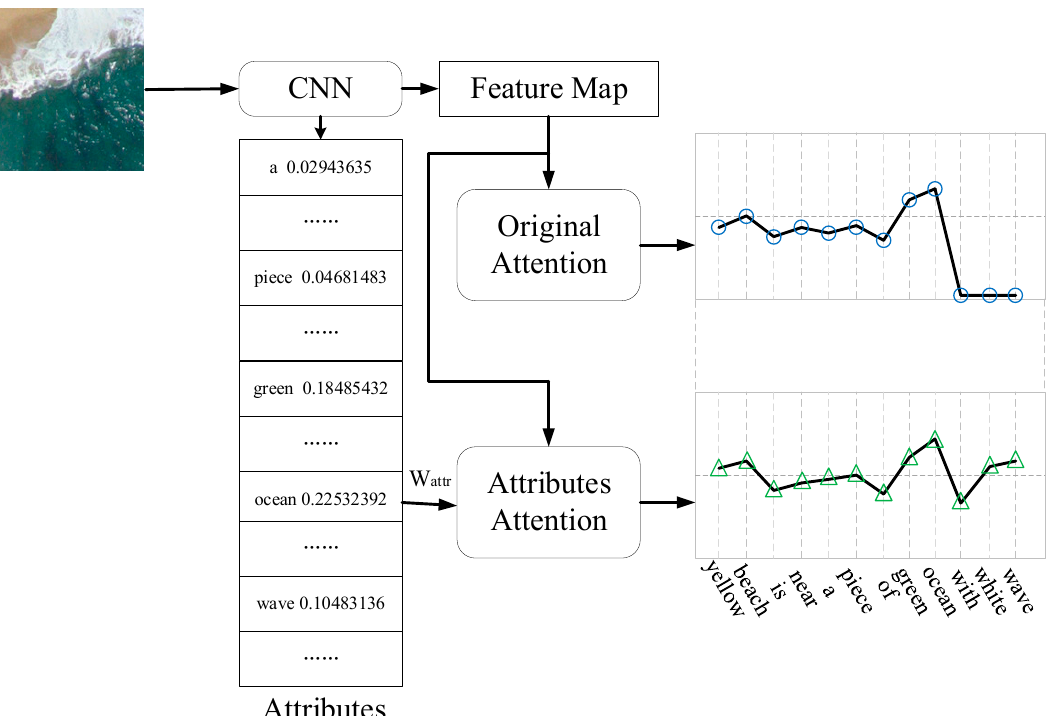
Figure 3. The construction and comparison of the original attention and the proposed attribute attention.